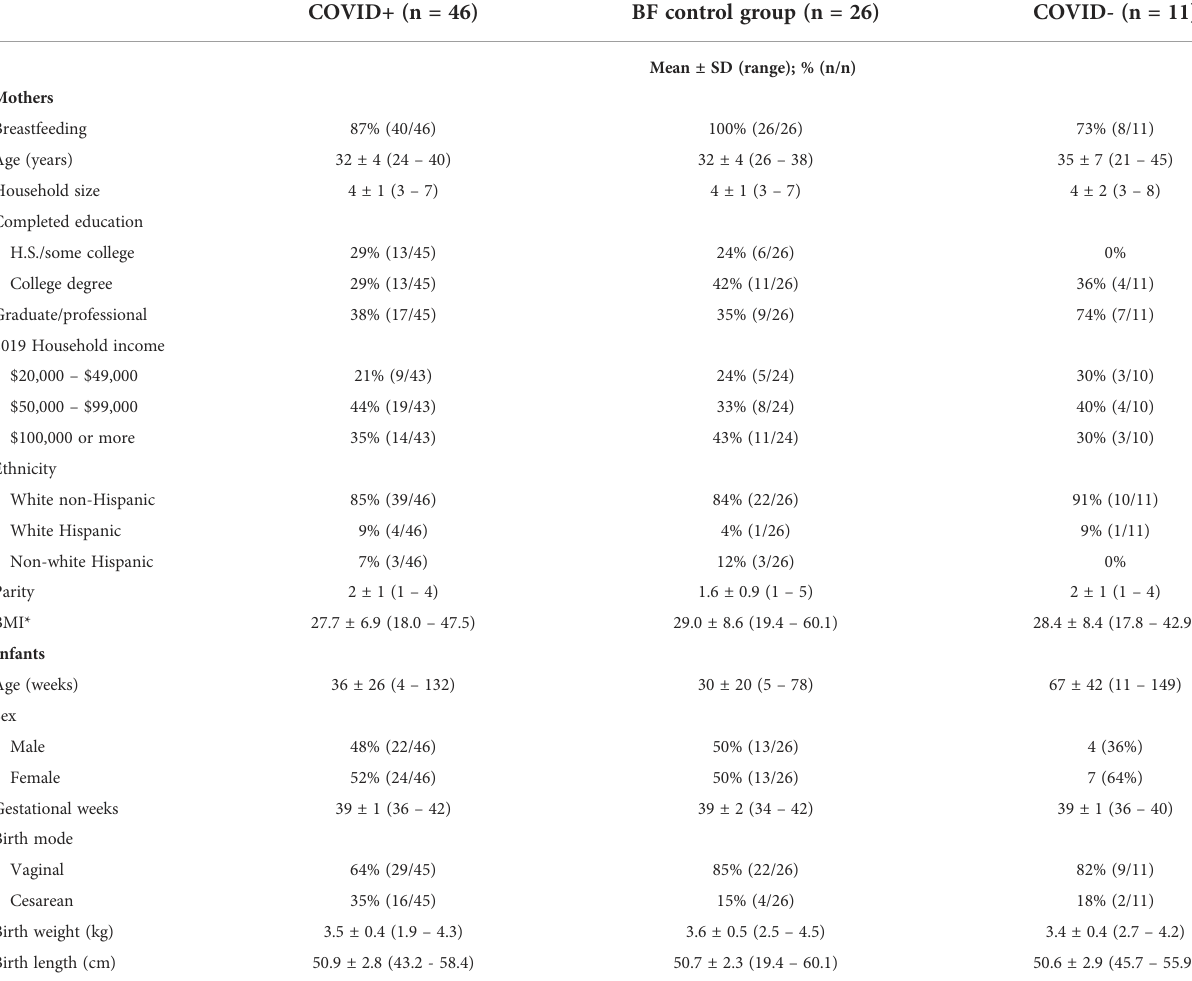
TABLE 1 Characteristics of mothers and infants at enrollment, by enrollment